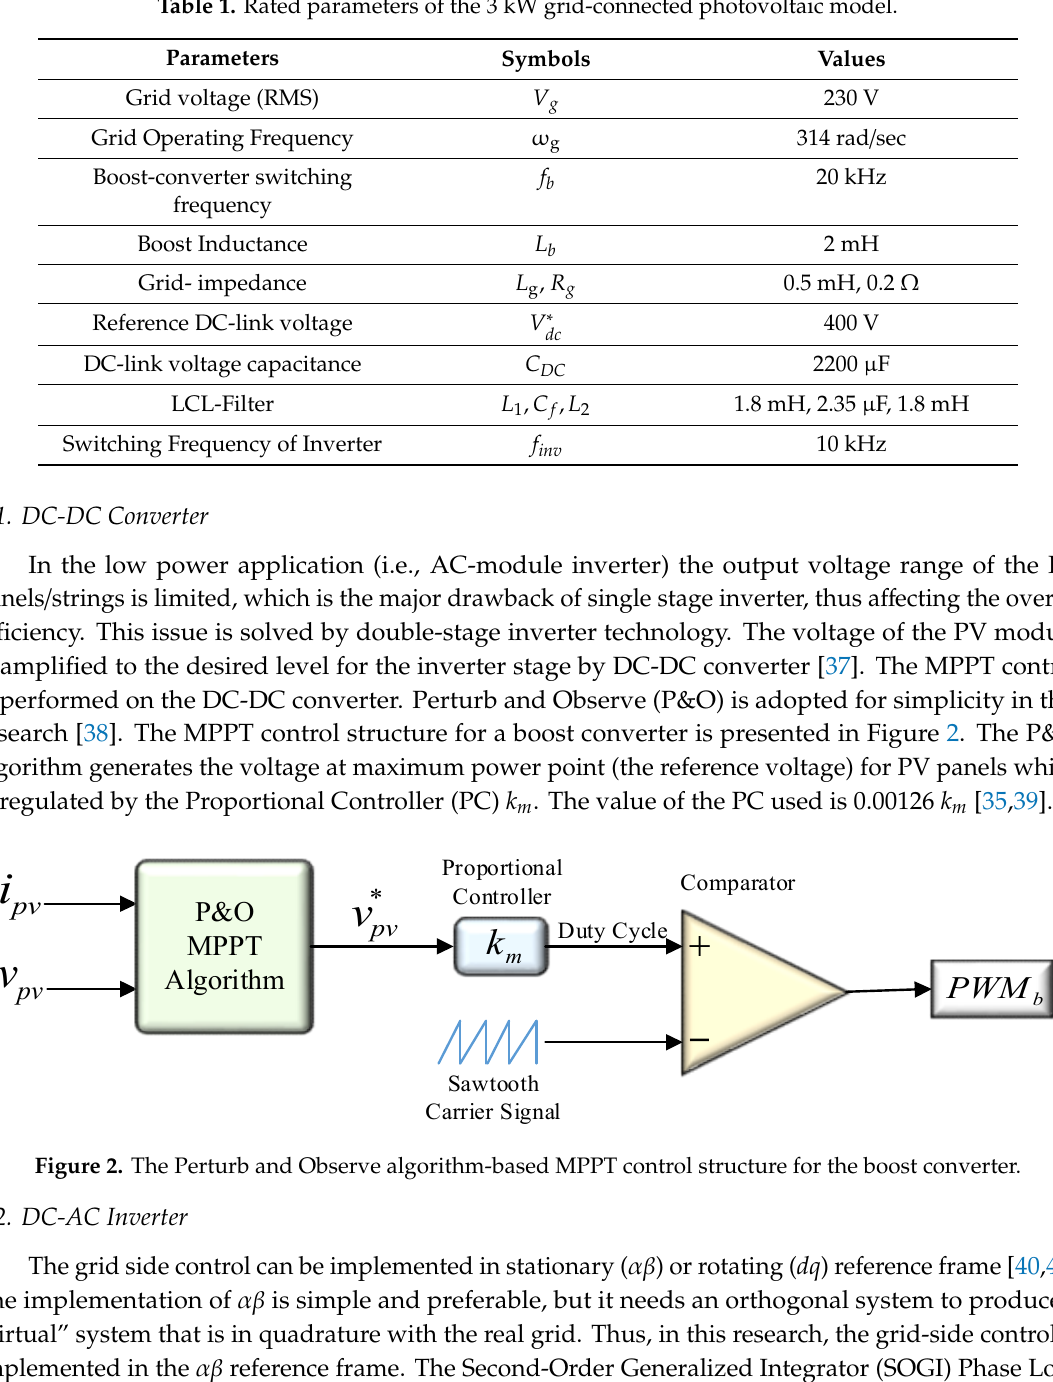
Figure 3. The proportional resonant controller with the resonant harmonic compensator. 3. Control of Transformerless PV Inverter 3.1. Control Loop Design